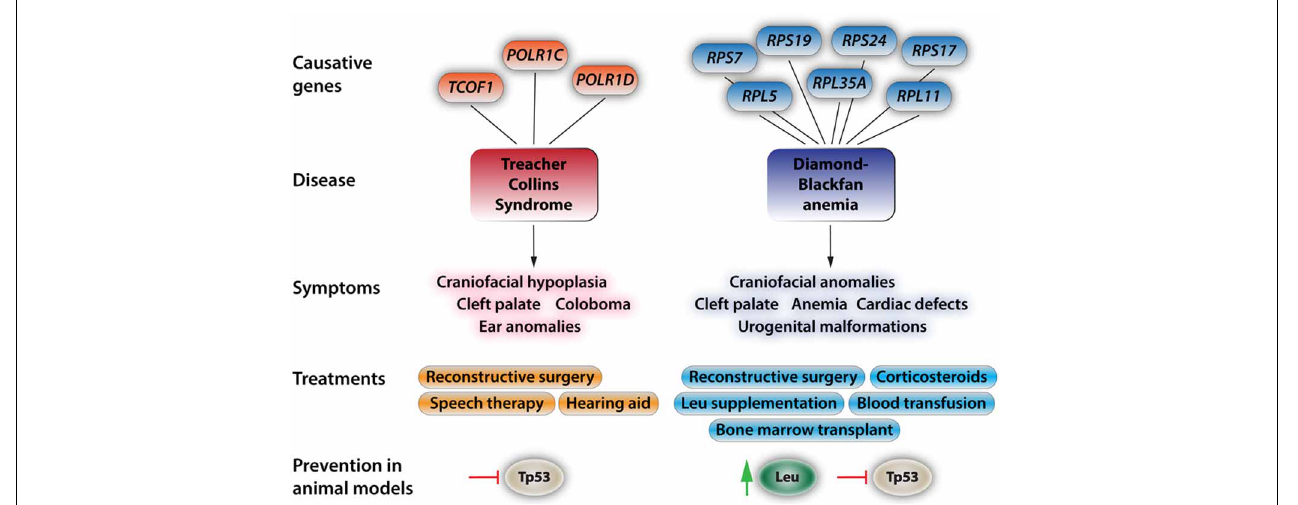
Diamond-Blackfananemia. Atthetop,thediagramdepictsknowngeneswith